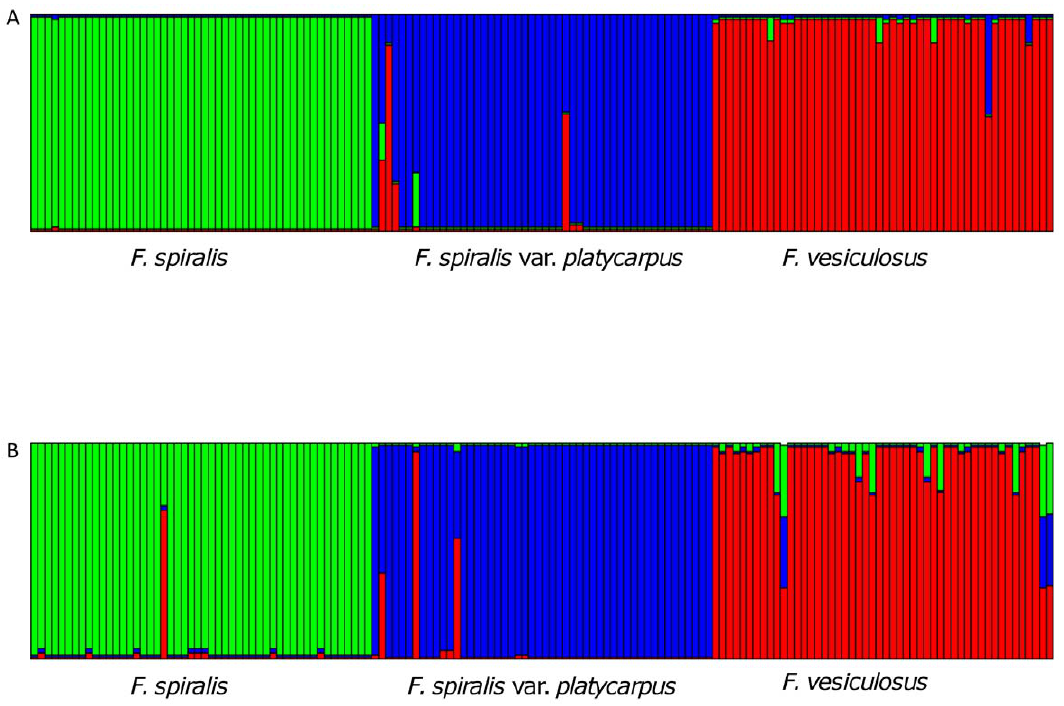
Figure 3. Results of the Bayesian analysis. Summary plot of the Bayesian analysis performed using STRUCTURE software on microsatellite data of samples from (A) Viana and (B) Roscoff, suggesting a K=3 best describing the situation among samples. Each vertical bar represents a different individual and length color is proportional to the inferred cluster. All individuals belonging to a morphological entity are generally assigned to the same cluster.